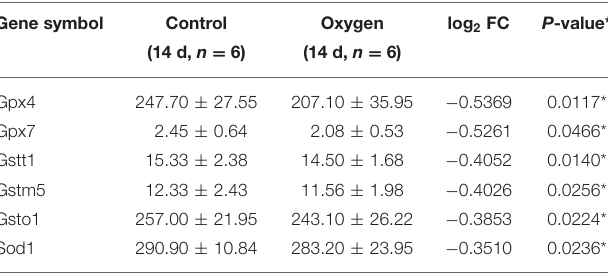
FPKM Values are expressed as mean ± SD. Differential expression analysis used with statistical significance set at * P < 0.05. FPKM, Fragments Per Kilobase of exon model per Million mapped fragments; FC, Fold